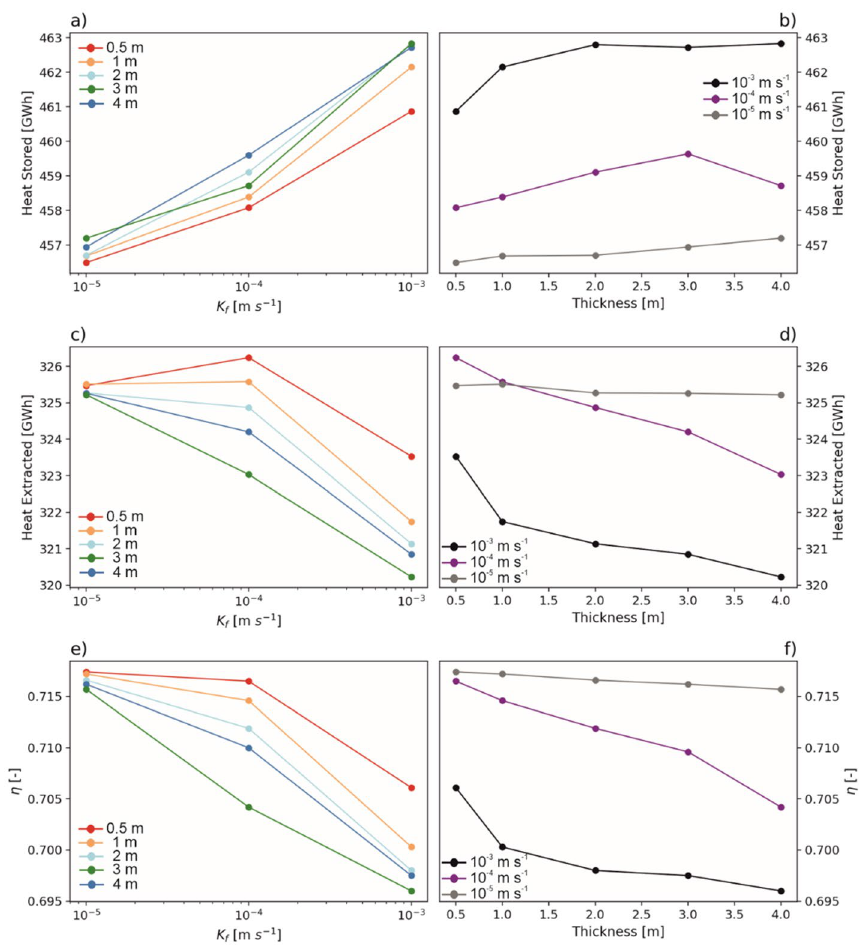
Fig. 11 Influence of the hydraulic conductivity and fault thickness on the amount of heat stored into the MD-BTES, the heat extracted, and the storage